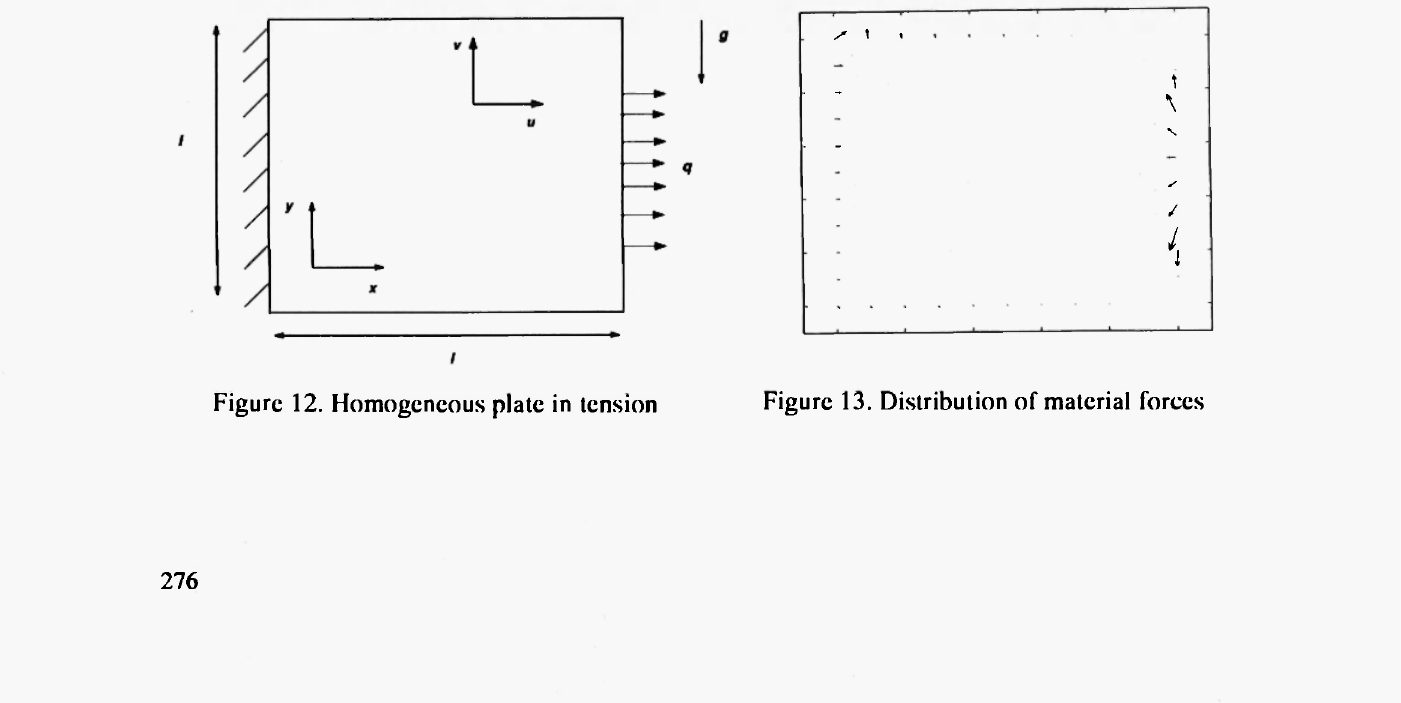
Figure 12. Homogeneous plate in tension Figure 13. Distribution of material